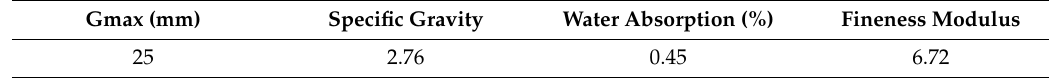
Table 3. Physical properties of the used coarse aggregates.